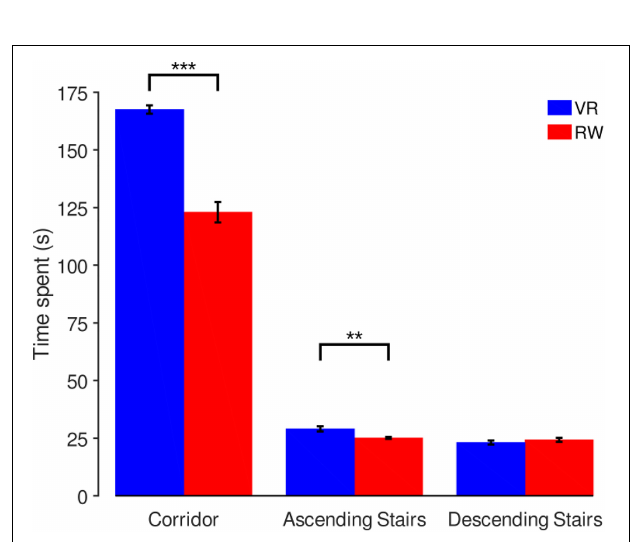
FIGURE 3 | 2D-Distribution of calibrated gaze position in head-centered coordinates, one sample participant shown. Dashed boxes indicate the manufacturer-specified tracking limits (Pupil Labs/VR: 100 × 110 ◦ , SMI/RW: 60 × 46 ◦ ), red data points are outside the specified tracking limits, but the side (left/right and up/down) relative to the limits is still well-defined.